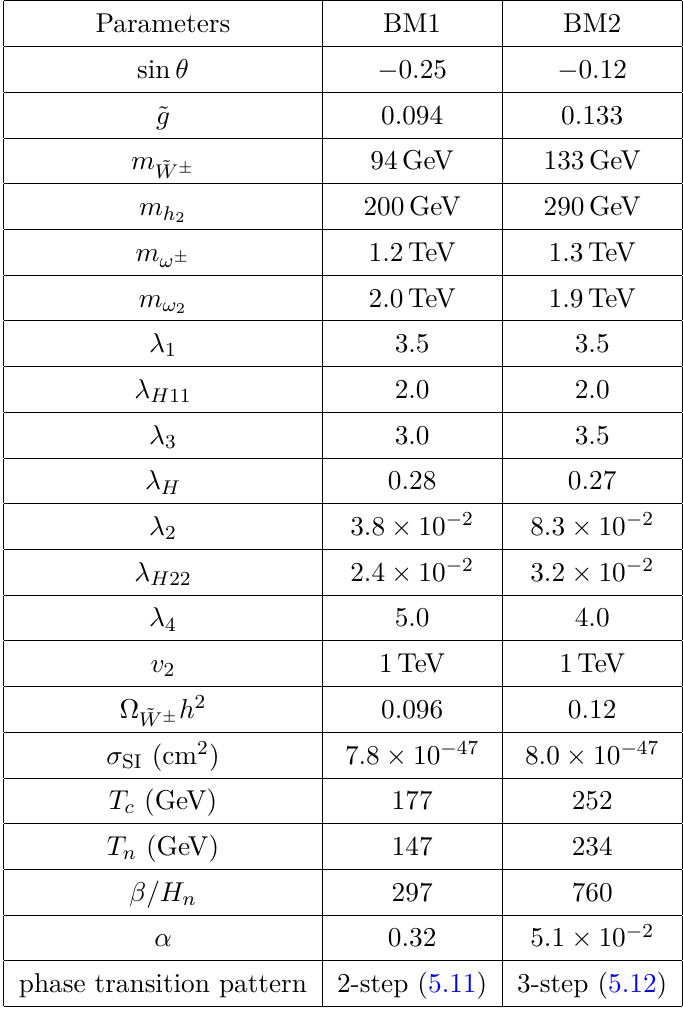
Table 2. Model parameters and calculated physical quantities with two benchmark points, BM1 and BM2. The independent model parameters in eq. (3.6) are listed in the upper part of the